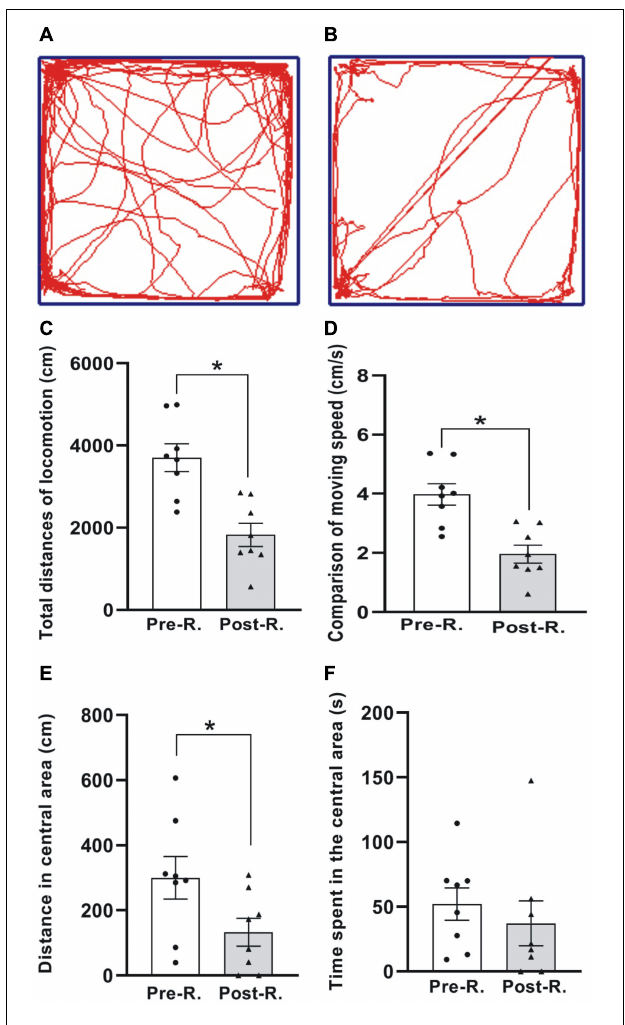
FIGURE 3 | The open field test (OFT) of locomotion. (A,B) The digitized ambulatory traces exemplified by one animal before and after rotary stimulation, respectively. (C–F) Comparison of average total distance traveled (C) , moving speed (D) , moving distance (E) , and the time spent (F) in the central area for the animals between before and after rotation ( *p < 0.05, n = 8. Wilcoxon paired-test). See legend in Figure 2 for